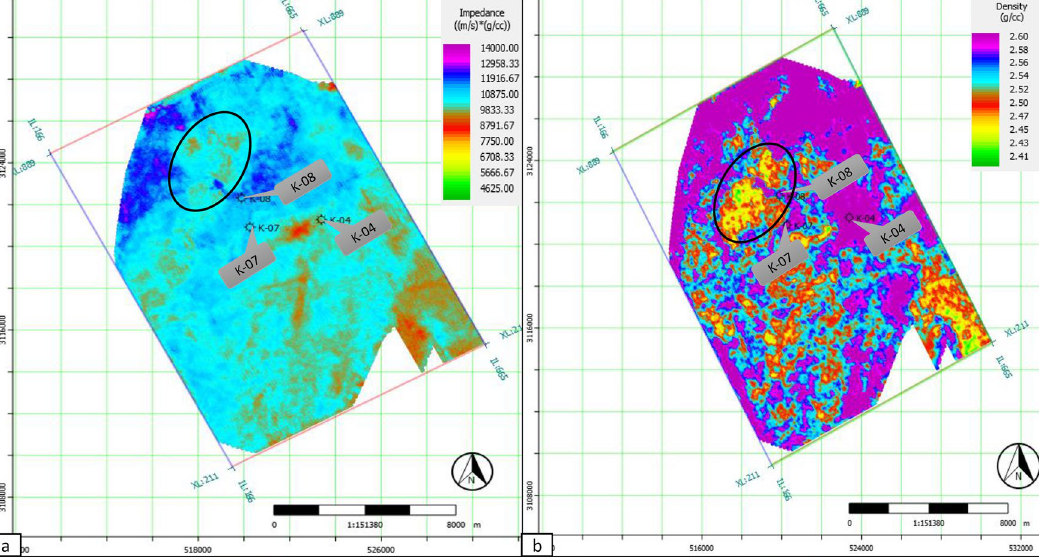
Fig. 16 a p -impedance and b density time slice at reservoir (S1)